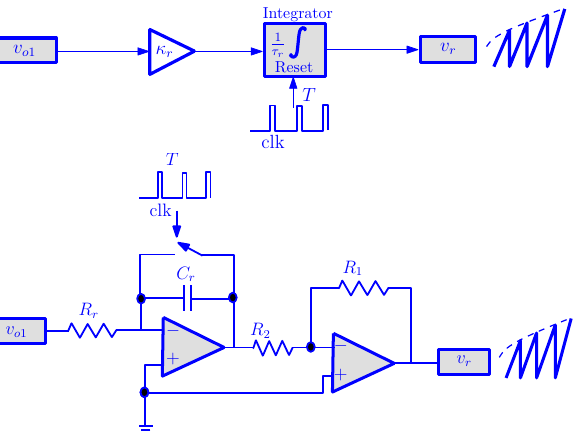
Figure 12. The block diagram ( top ) and the equivalent schematic circuit representation ( bottom ) of the adaptive compensating slope signal generator.